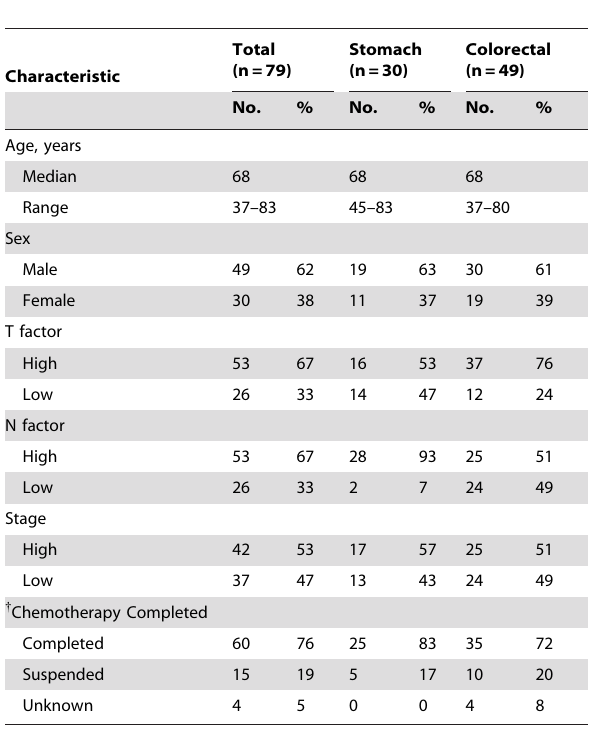
Table 1. Postoperative Clinicopathological Characteristics in Cancer Patients for 5-FU Based